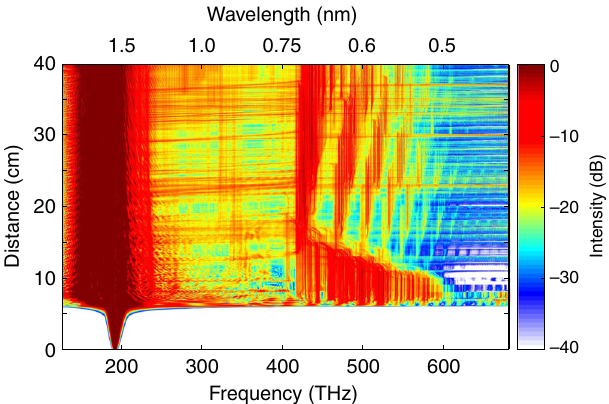
Fig. 3 Spectral evolution in a tapered multimode fi ber as obtained from a generalized Unidirectional Pulse Propagation Equation simulation. A 400- fs, 1550 nm pulse with a peak power of ~50 kW is injected in a 40 cm long tapered multimode fi ber, whose core radius decreases from 40 to 10 µ m. After only a few centimeters of propagation, the input pulse undergoes a soliton fi ssion and a sequence of dispersive waves emerges in the visible. Upon further propagation, the generated multimode solitons experience fi ssion-like processes (red horizontal lines) that almost immediately expand the spectrum and generate new blue-drifted dispersive wave